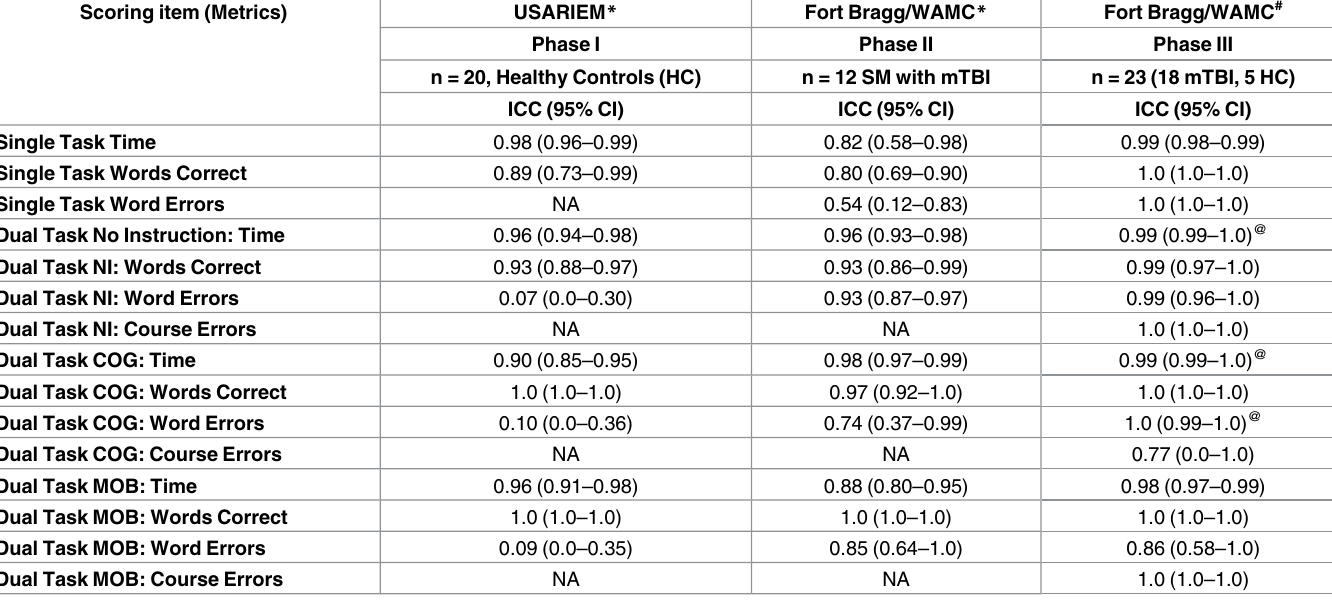
Table 3. Illinois Agility-Packing List